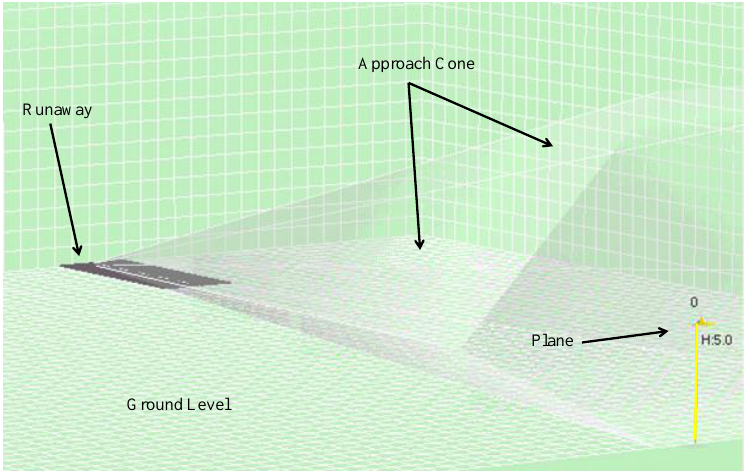
Figure 10. Simulation visualization tool.